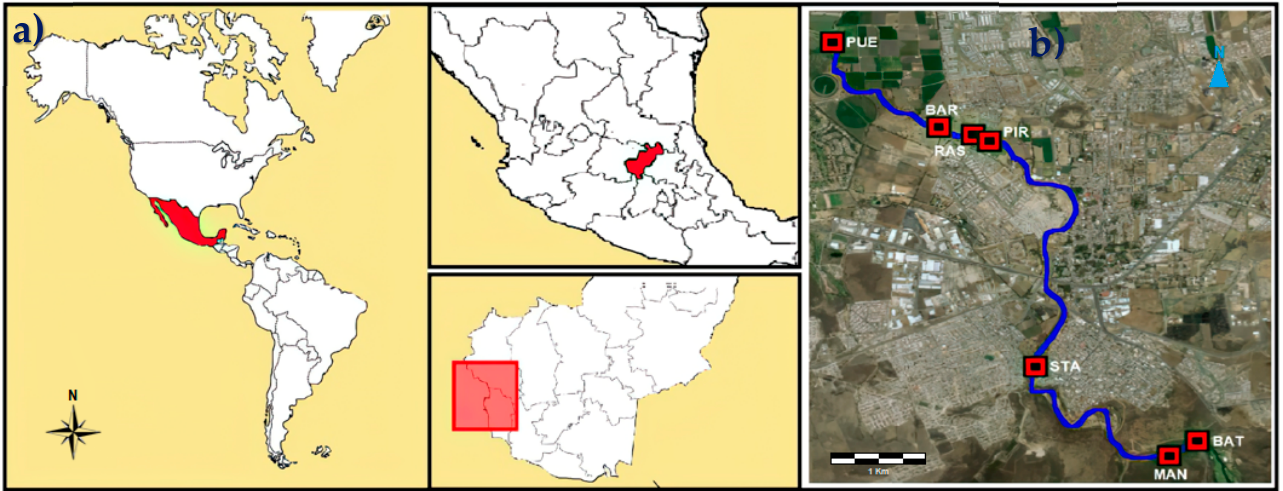
Figure 1. Map of the study area. The blue line represents El Pueblito river, located in Corregidora, Queretaro, Mexico; the sampled sites are indicated with red squares. ( a ) location of: Mexico in America continent, Queretaro state in central Mexico and Corregidora city; ( b ) El Pueblito river study area. Note: Maps throughout this article were created using ArcGIS ® software by Esri (Redlands, CA, USA). Table 1. Coordinates of the sampled sites.